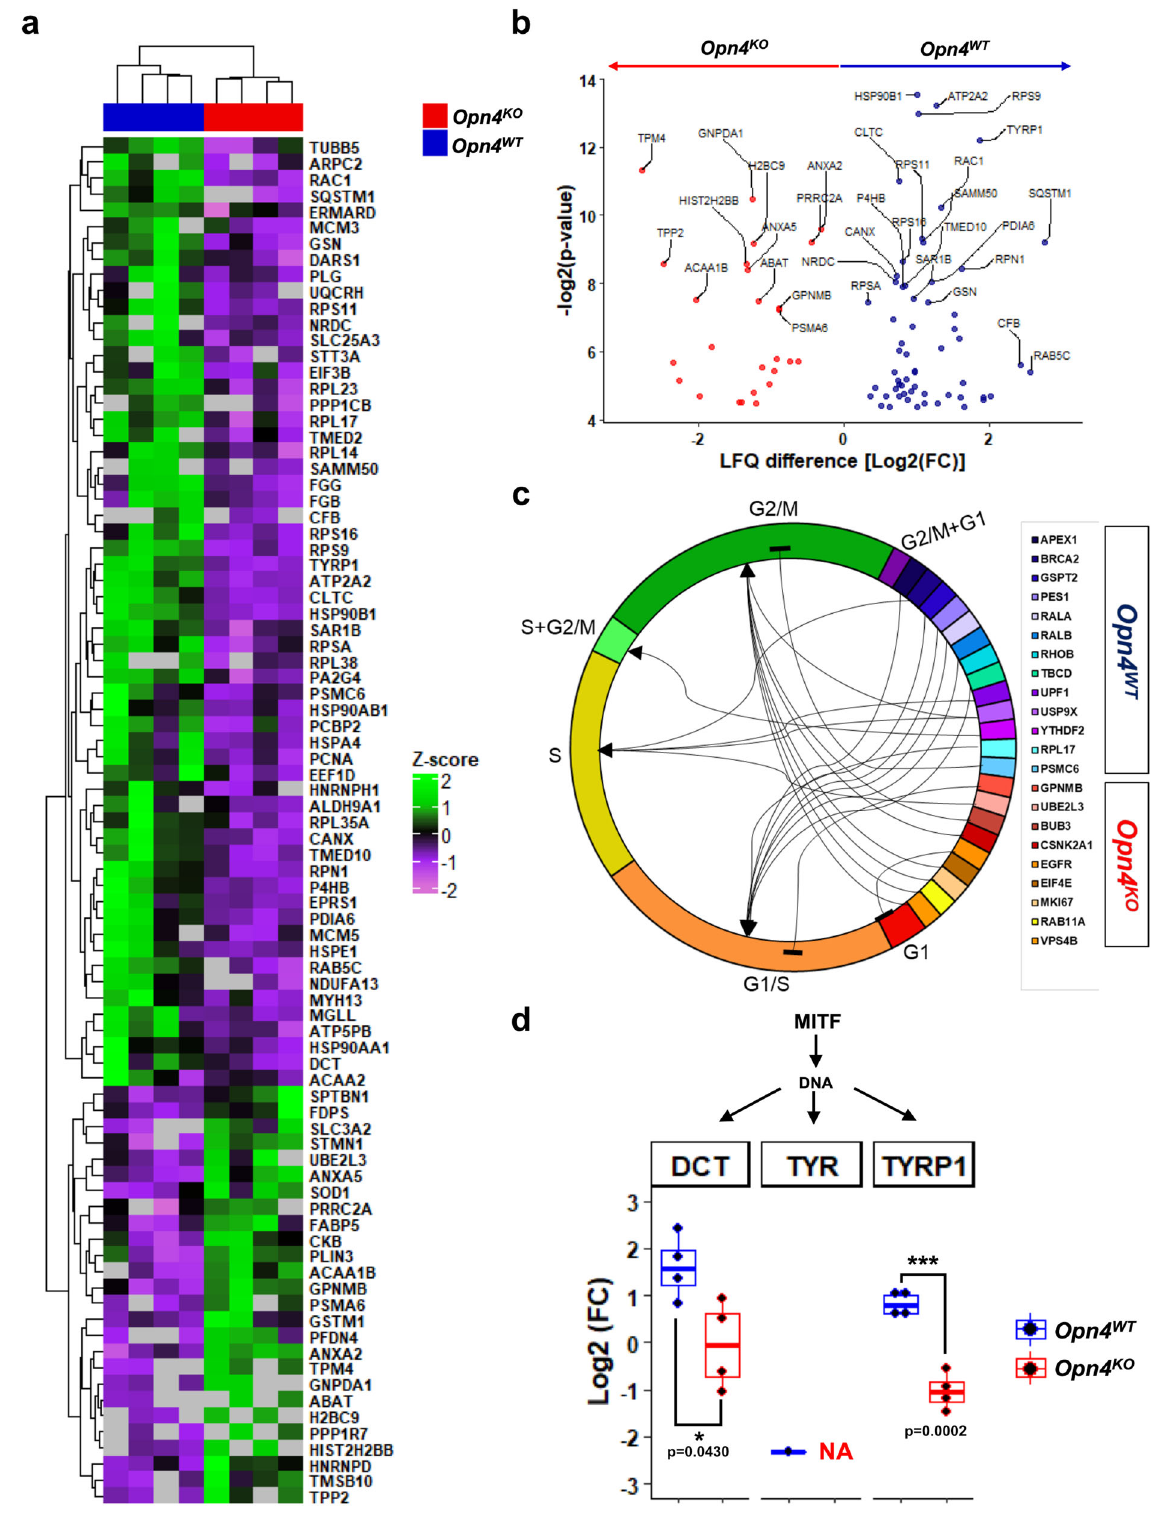
Fig. 7 Identi fi cation of differentially expressed proteins and their participation in cell cycle regulation and MITF signaling. a Heatmap of 85 differentially regulated proteins in Opn4 WT and Opn4 KO tumors. Signi fi cance was determined by two-sided t- test ( p < 0.05) and FC ≥ 1.2 [log2(FC) ≥ 0.26 or ≤ − 0.26]. b Scatter plot showing the distribution of signi fi cantly regulated proteins in LFQ analysis. Proteins with higher fold change and statically signi fi cant values are shown. c Differentially encoded proteins among melanoma types showed GO-term related to different cell cycle phases. This shows the speci fi c relationship between proteins and cell cycle progression. Arrows and blunt arrows represent positive and negative regulation, respectively. d Boxplots of MITF target proteins (DCT, TYR, and TYRP1) differentially encoded by Opn4 absence, which were associated with melanogenesis (tyrosine metabolism) pathway and melanoma. n = 4 for each group comprised of independent